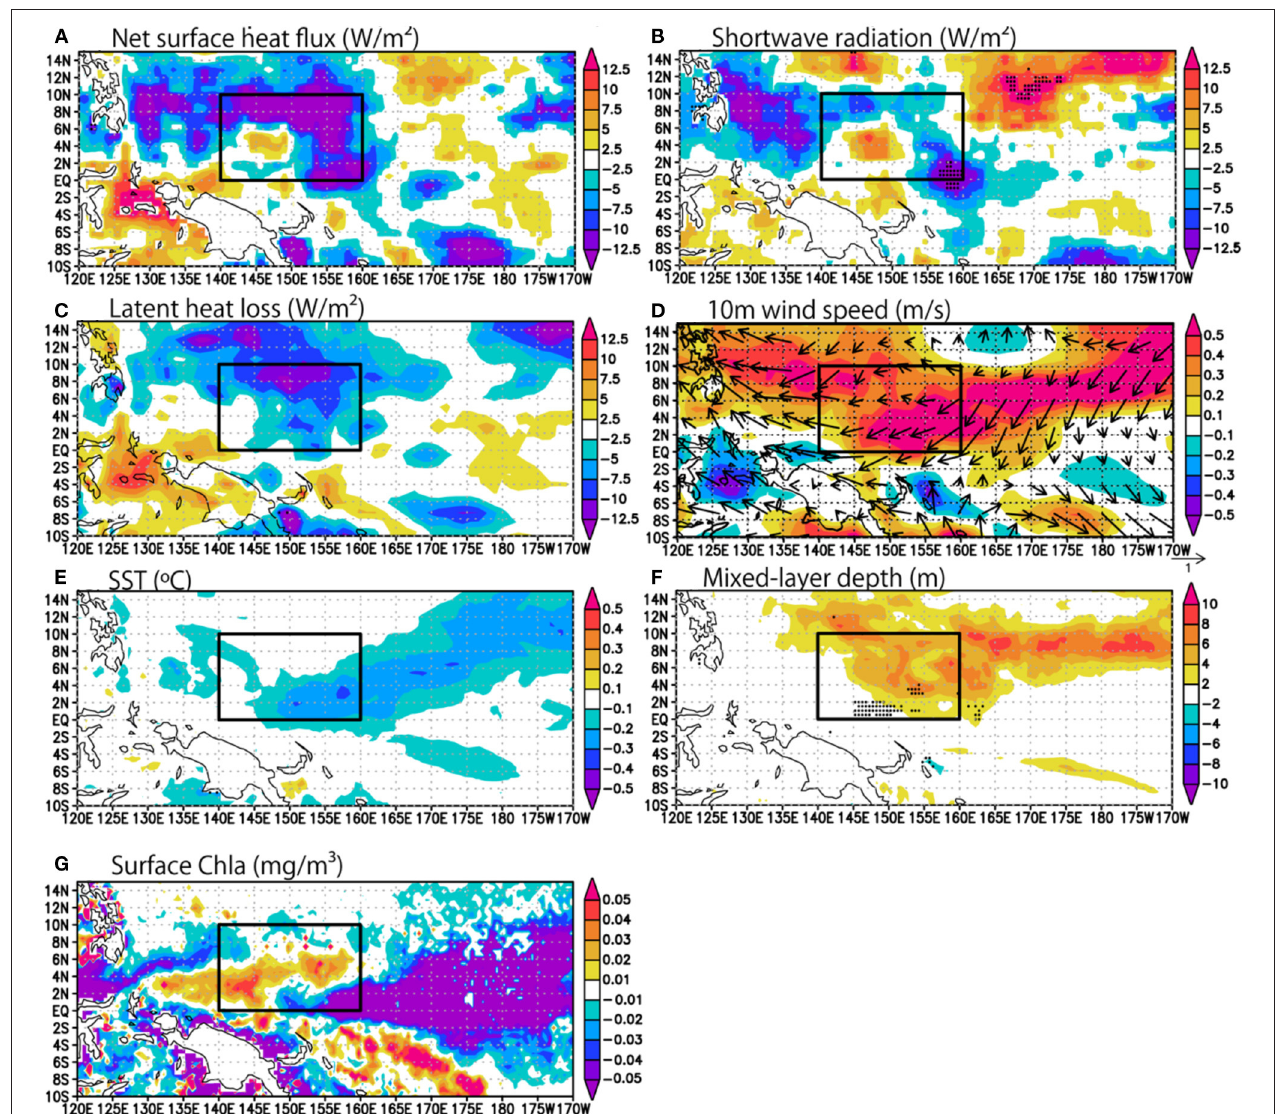
FIGURE 7 | (A) Differences in the net surface heat flux anomalies (W/m 2 ) averaged in April 2015 of the ensemble mean predictions (F2chT minus F2). Black dots indicate the statistically significant difference in the ensemble means between F2 and F2chT beyond the 90% confidence levels on paired t-test. (B) Same as (A) , but for the shortwave radiation (W/m 2 ). (C) Same as (A) , but for the latent heat loss (W/m 2 ). (D) Same as (A) , but for the 10m wind (m/s, vector) and speed (m/s, shade). (E) Same as (A) , but for the SST ( ◦ C). (F) Same as (A) , the mixed-layer depth (m). (G) Differences in the Chla (mg/m 3 ) in F2chT minus